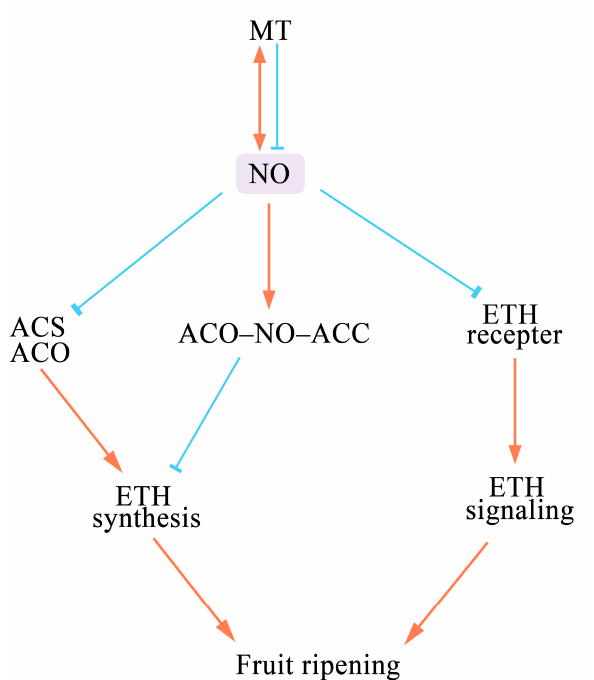
Figure 2. A schematic model of how NO affects the senescence of fruits. (“ ↓ ” indicates promote, and “ ⊥ ” indicates inhibit). NO affects fruit ripening and senescence by altering ETH synthesis and signaling. It can down-regulate the activities of the ETH synthesis-related enzymes ACS and ACO to reduce ETH production. NO can also form a stable ternary ACO–NO–ACC complex to antagonize ETH formation. NO inhibits the ETH signaling pathway by down-regulating the expression of ETH perception genes. MT acts upstream of NO and can induce or inhibit NO production to regulate the senescence of fruits and vegetables. NO also induces the synthesis of MT in plants.